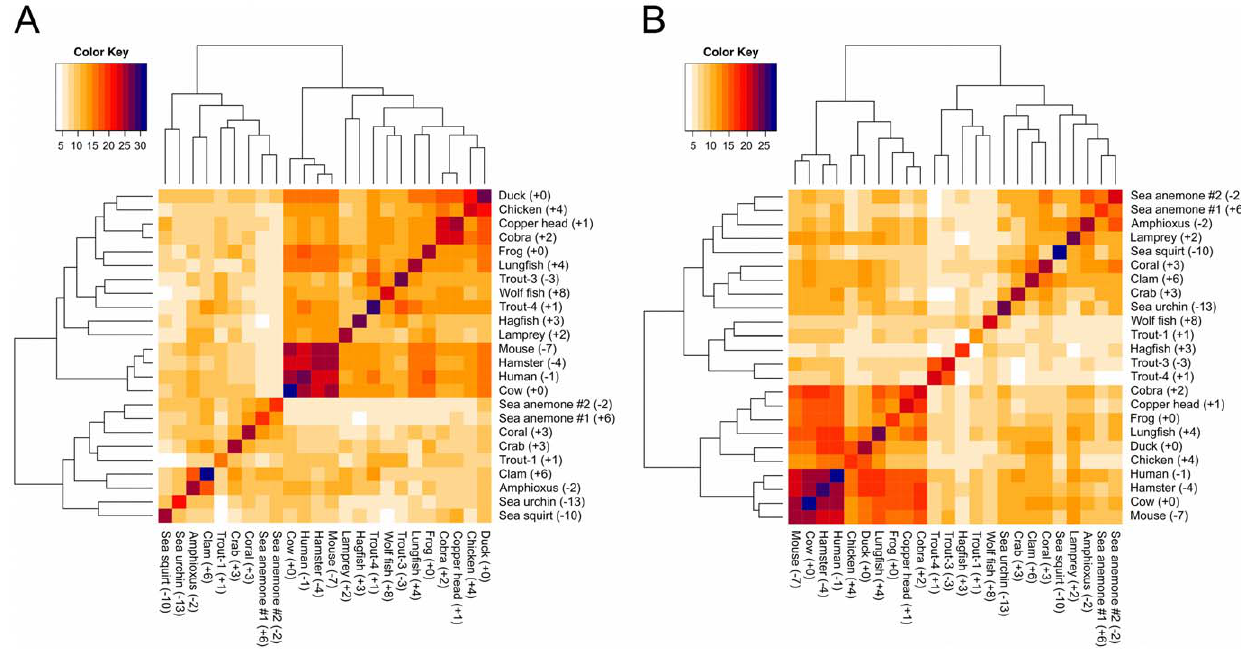
Figure 6. Charge similarity clustering for the two sides of C3d. Dendrograms with distance matrix heatmaps illustrate clustering of the 24 C3d homologues based on the number of positions with the same charge within the two functional regions: (A) CR2-face and (B) thioester-face. Net charge of each homologue is provided in parentheses.